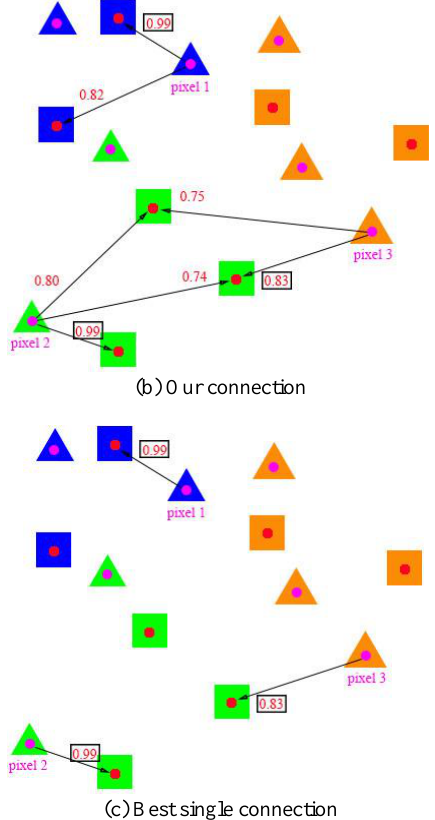
Fig 4. Majority voting strategy between source and